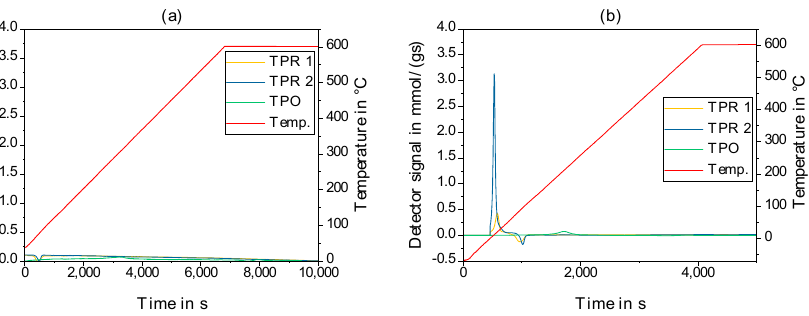
Figure 8. Results of TPROR measurements of the palladium-silica system: ( a ) 40 °C to 600 °C ( b ) − 68 °C to 600 °C with a maximum of reduction (TPR 2) at about 10 °C and a negative signal due to desorption of hydrogen at about 90 °C.